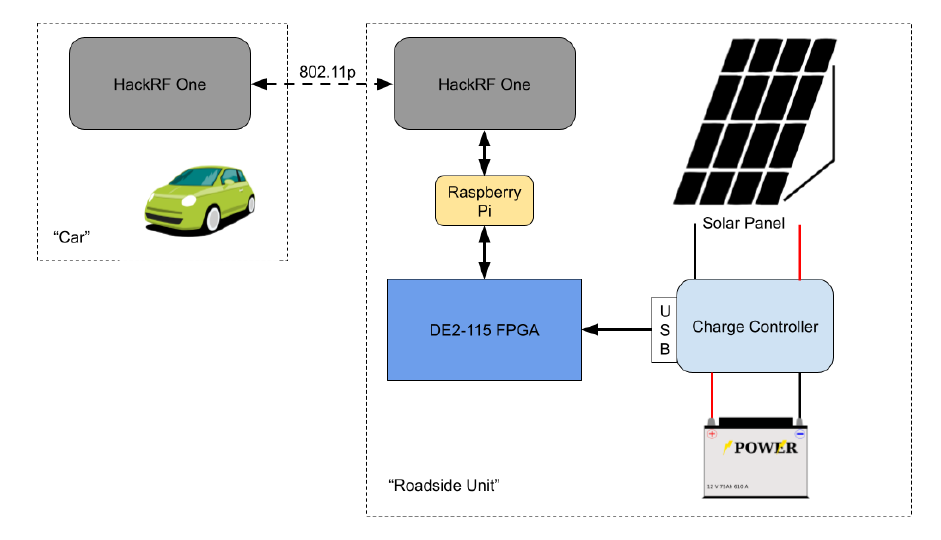
Figure 6. Block diagram of main components of the RSU and the test car.